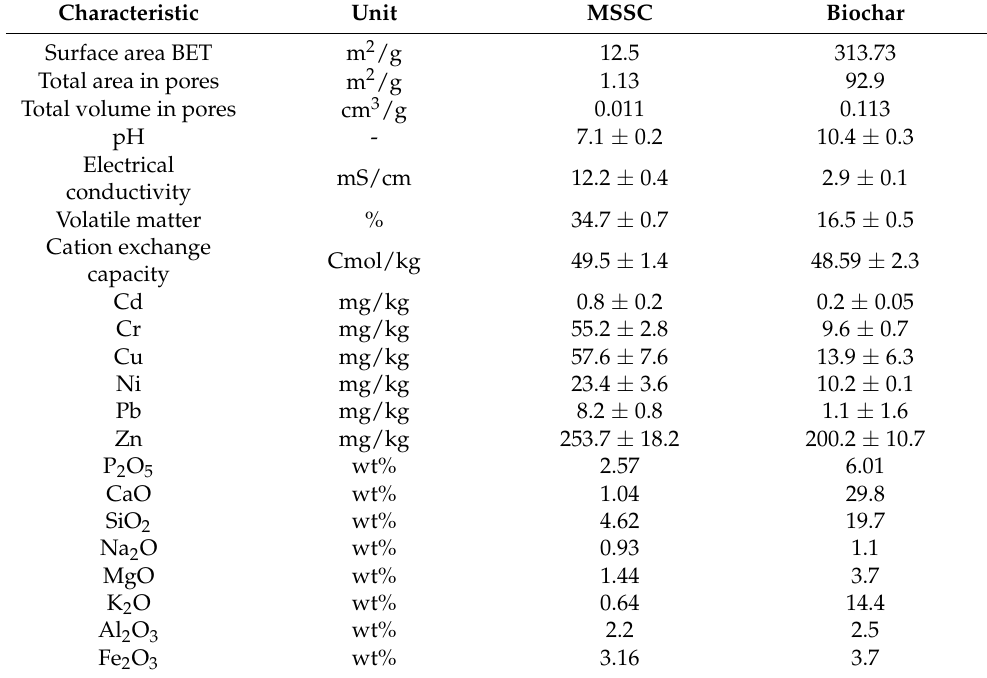
Table 1. Selected physical and chemical characteristics of MSSC and biochar (n = 3 ± standard